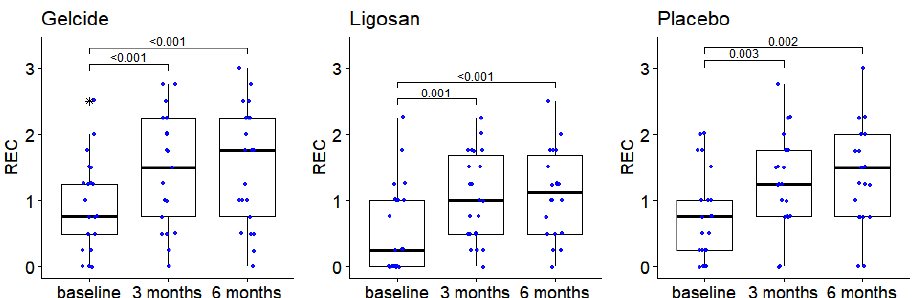
Figure 4. The evolution of the REC between successive time points in the three groups (numbers in brackets represent p -values of Wilcoxon tests for pairwise intragroup comparisons; p -values > 0.05 are not displayed), boxplot depicts median and interquartile range, large stars represent outliers; data points displayed as superimposed dot plots.